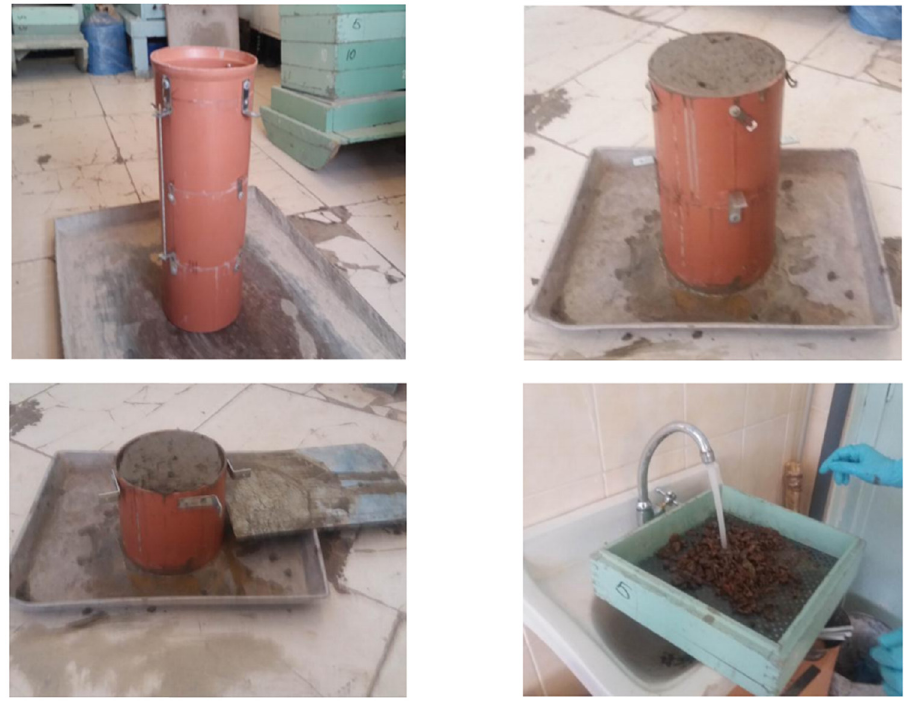
Figure 4: Determination of SCC resistance to segregation in a three - section cylinder.